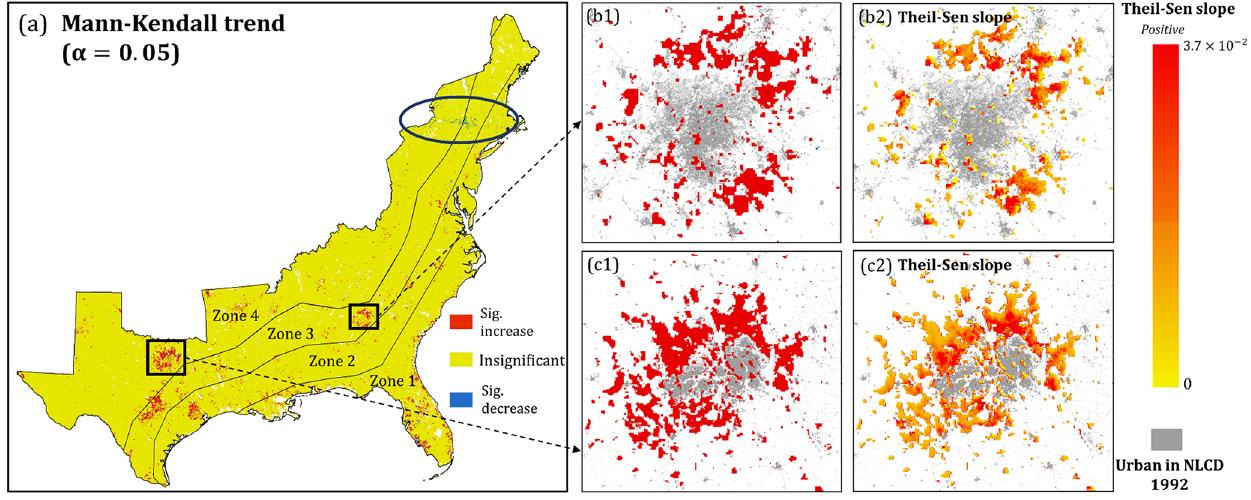
Figure 7. Maps of the 22-year Mann–Kendall trend and Theil–Sen slope in the study area. Two subsets are selected: Dallas (trend map in b1 and slope map in b2 ) and Atlanta (trend map in c1 and slope map in c2